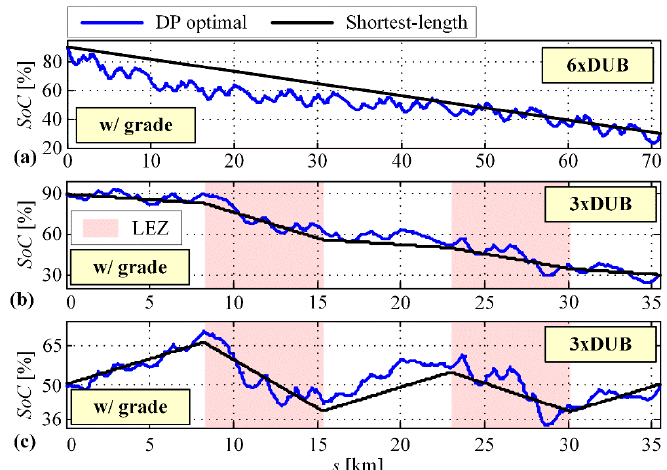
Figure 9. ( a ) Optimal SoC trajectories and corresponding shortest-length (piecewise linear) trajectories for 6xDUB driving cycle and ( b , c ) 3xDUB driving cycle in the presence of LEZs with different initial and final SoC values for recorded road grade profile from Figure 4b.